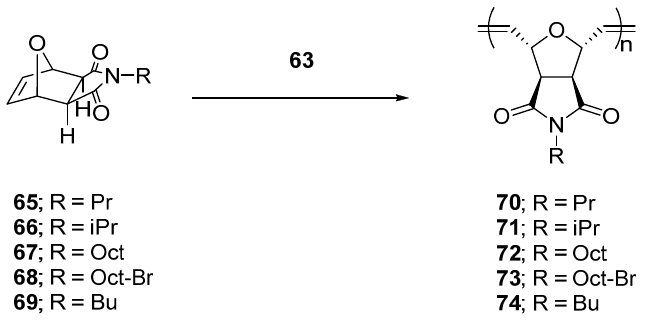
Figure 11. Polyisobutylene (PIB 1000 )-supported Grubbs second generation catalysts 63 and Grubbs catalyst 64